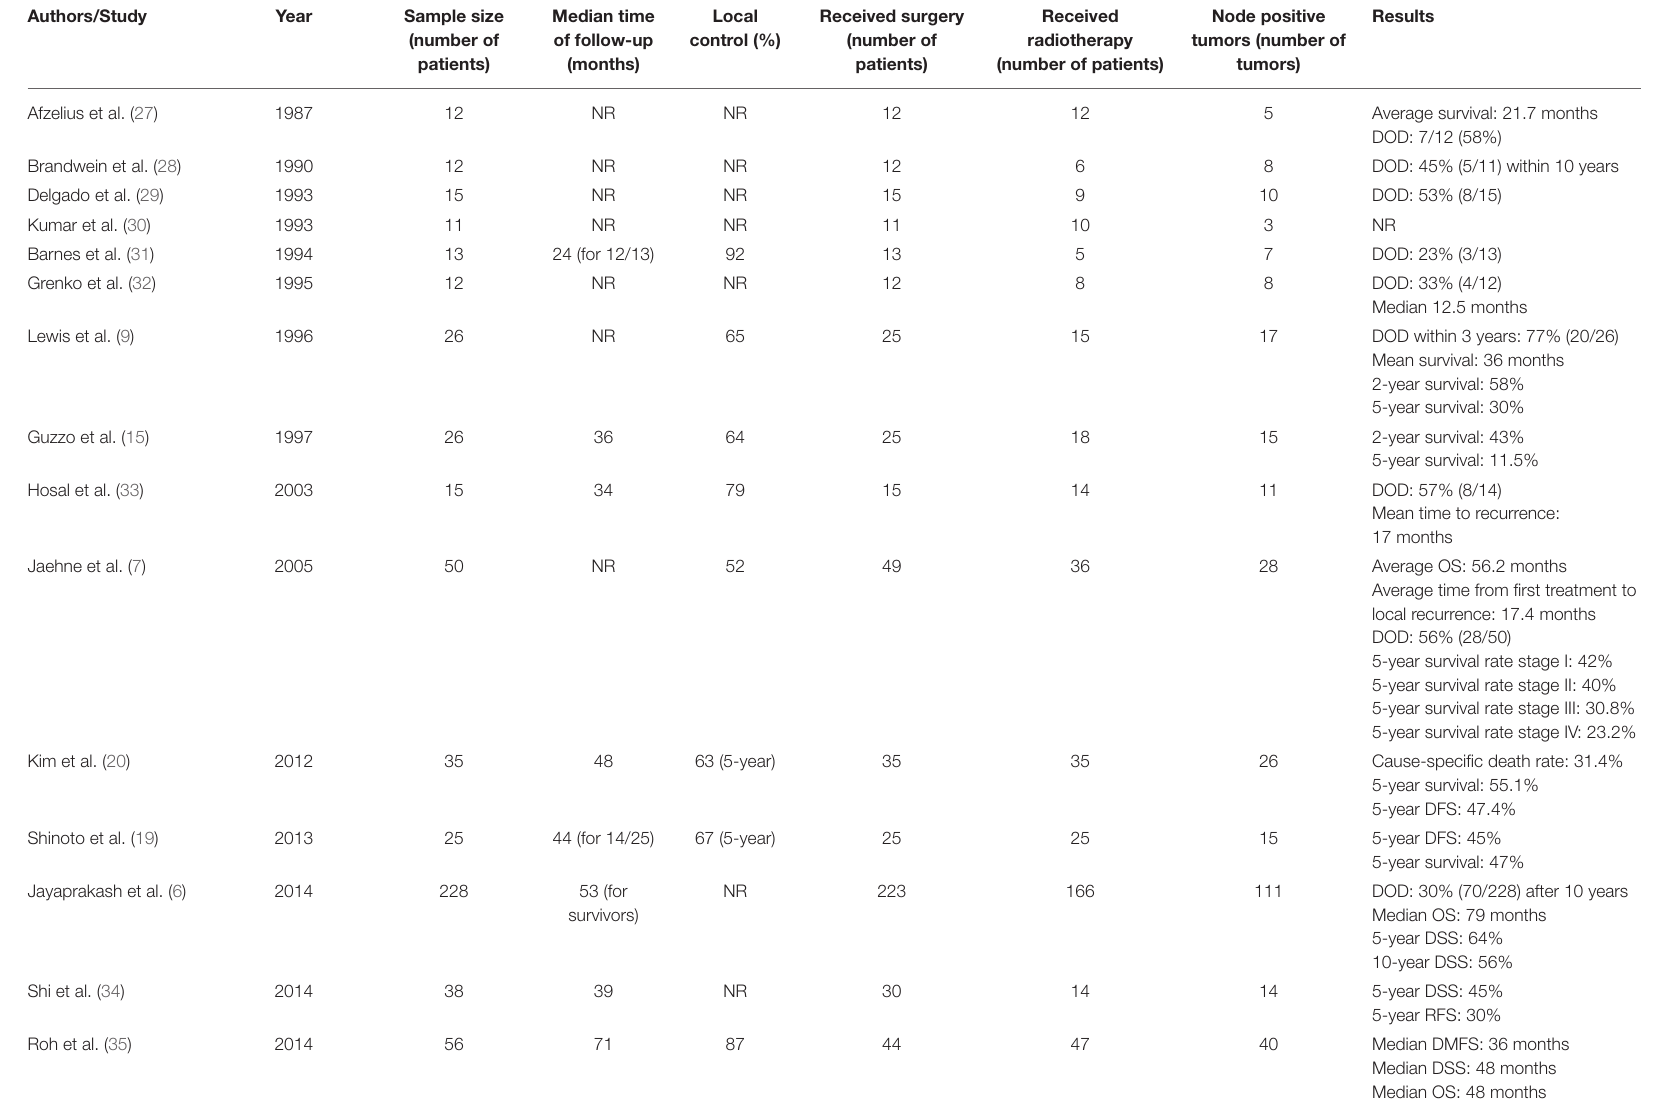
TABLE 2 | Overview of the literature regarding management of salivary duct